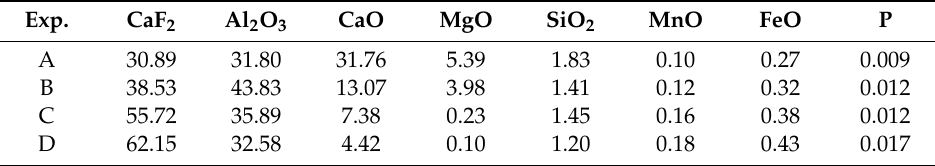
Table 2. Chemical compositions of the slag at the beginning of refining